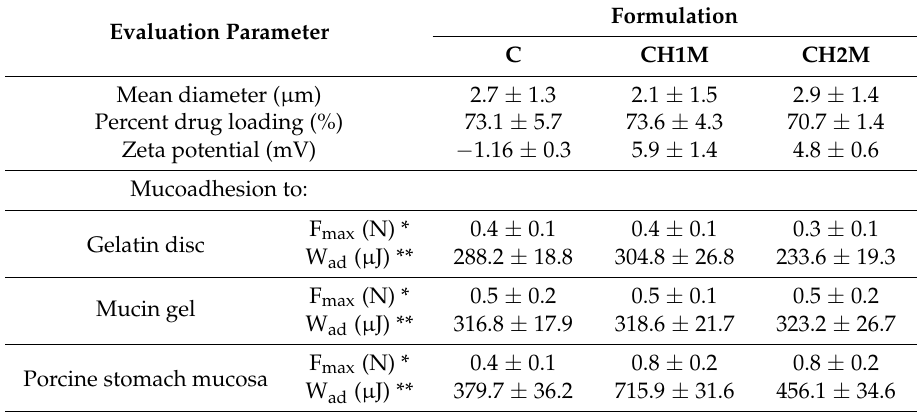
Table 4. Stability characteristics of non cross-linked microparticles formulation C and cross-linked